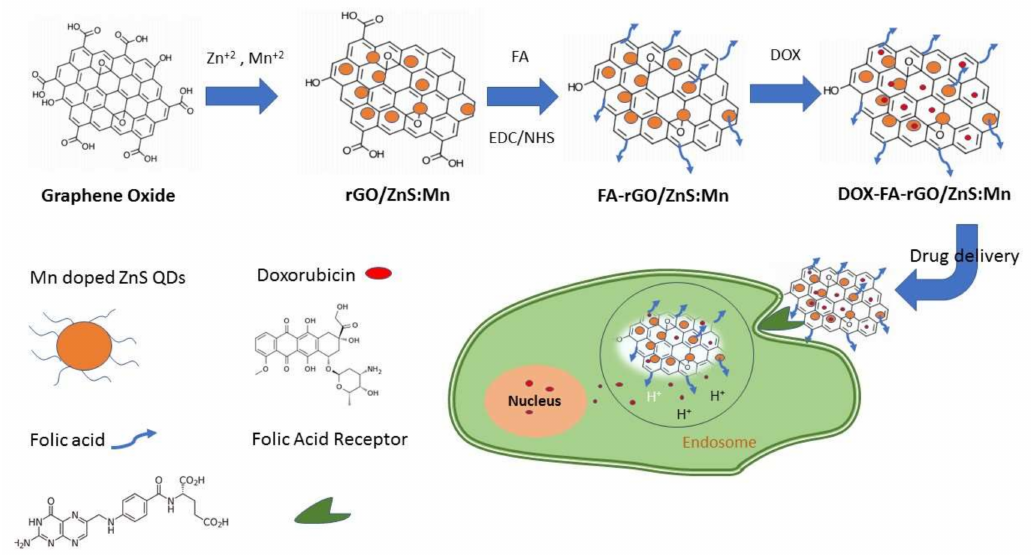
Scheme 1. Illustration of the preparation approach of FA-rGO/ZnS:Mn as a drug delivery system to release DOX into the cancer cell nucleus (drawn not to